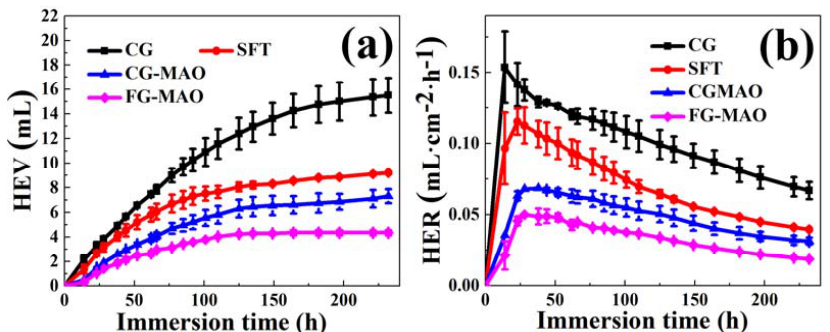
Figure 10. ( a ) Hydrogen evolution volume (HEV) and ( b ) hydrogen evolution rate (HER) curves of all samples immersed in SBF.